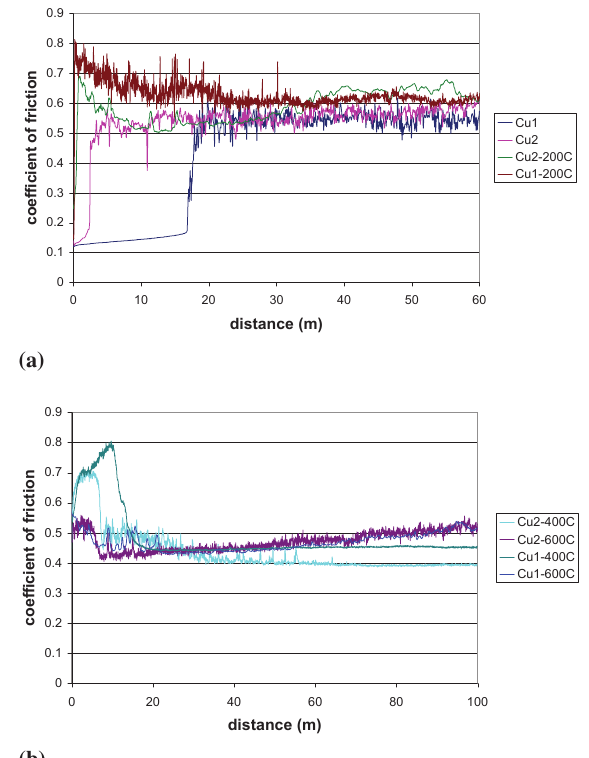
Figure 2. Experimental materials.